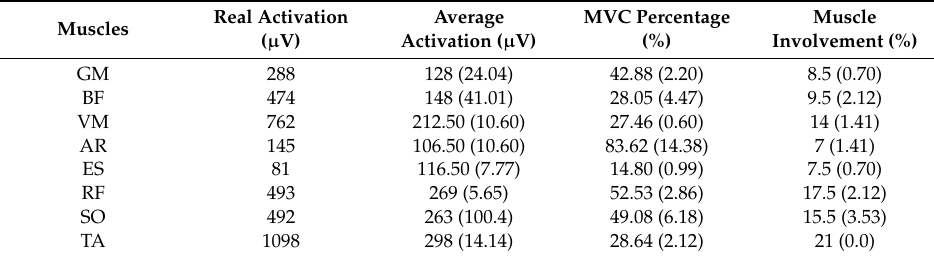
Table 1. Electromyographic descriptive variables (mean, SD).